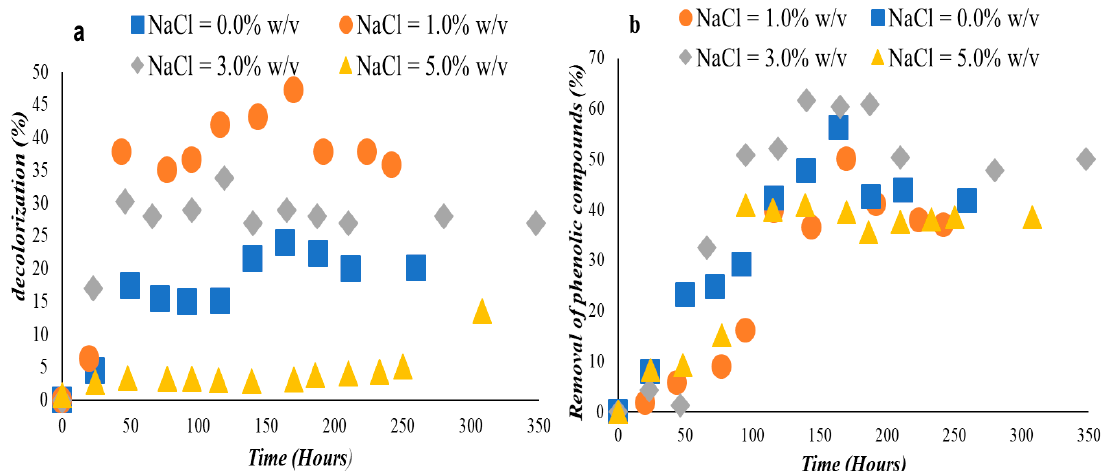
Figure 4. ( a ) Decolorization (%) and ( b ) Removal of phenolic compounds (%) from the culture medium when Yarrowia lipolytica ACA-5031 was grown in 0.0%, 1.0%, 3.0%, and 5.0% NaCl containing 2.0 g / L phenolic compounds.